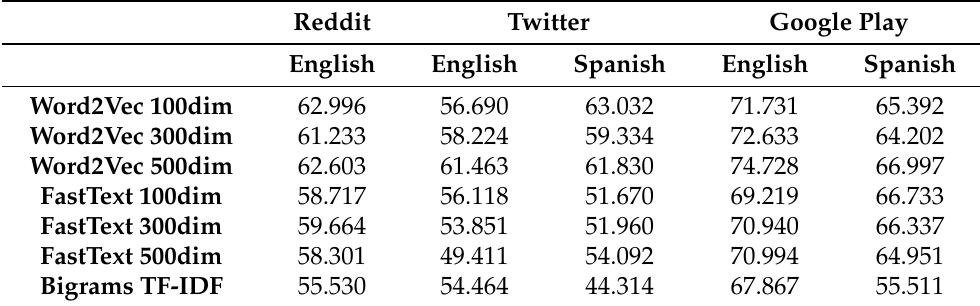
Table 7. Transfer Learning F-Score results.